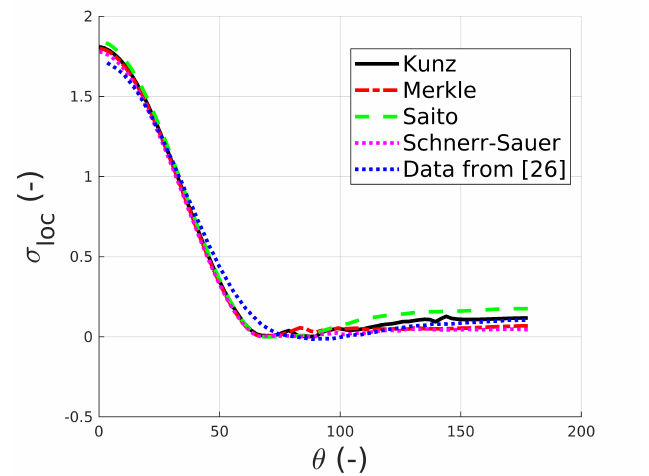
Figure 13. Time averaged local σ on the cylinder surface, results obtained considering standard coefficients (Table